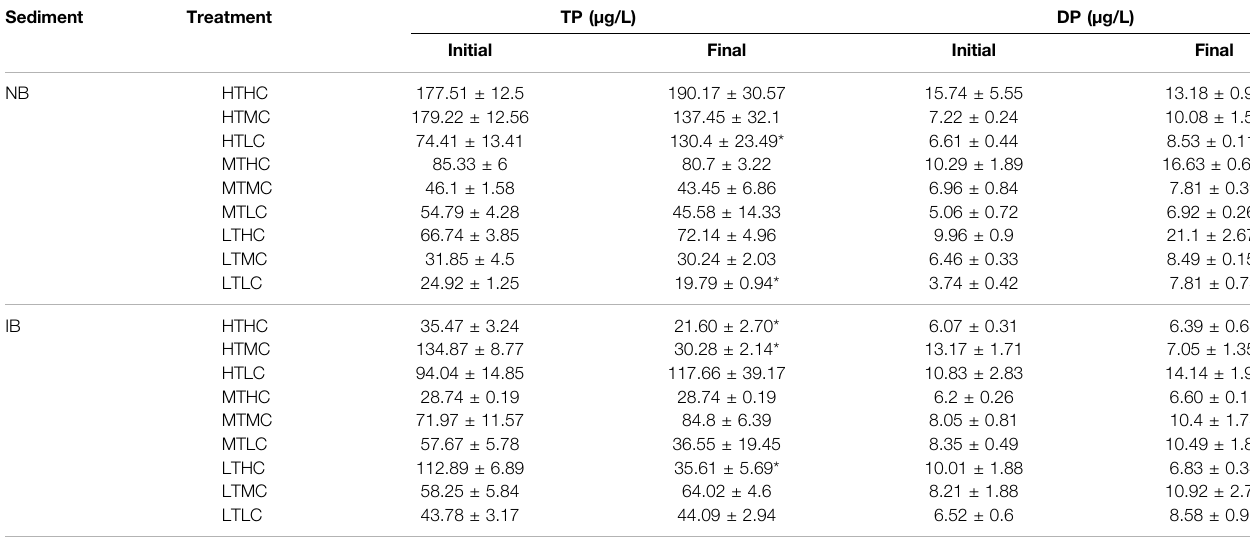
TABLE 6 | Total phosphorus (TP) and dissolved phosphorus (DP), by sediment type (NB and IB) at the beginning and end of the experiments. Sediment